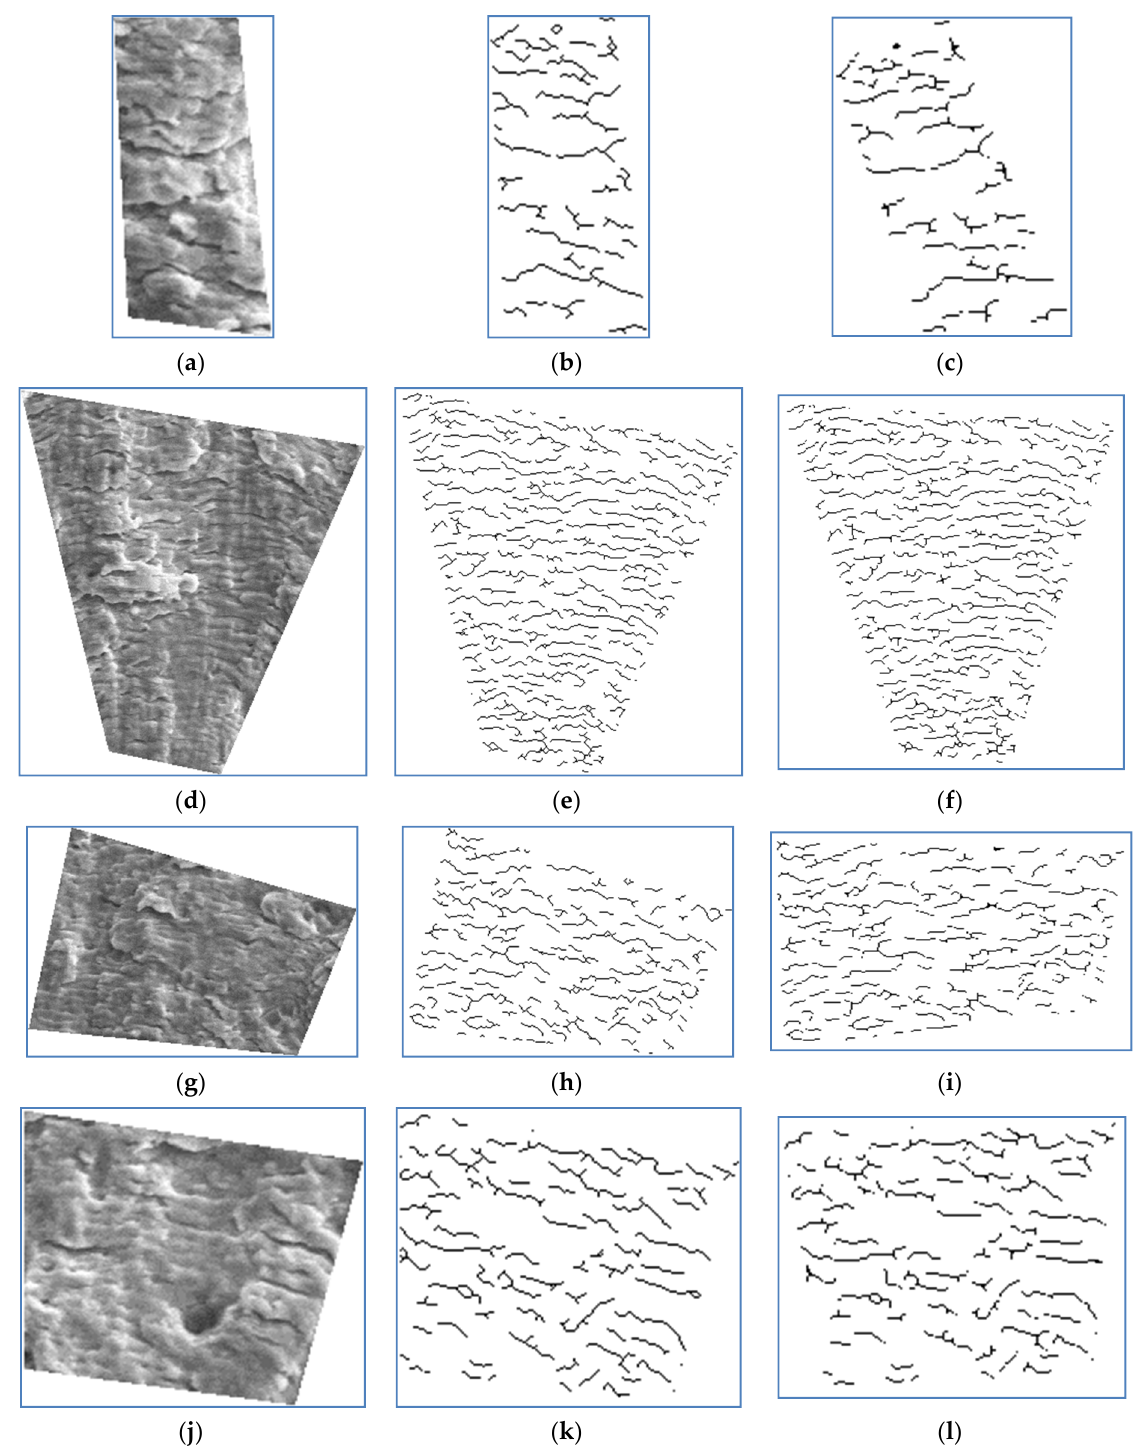
Figure 6. Fragments 1–4 ( a , d , g , j ), highlighted on the fractographic image in Figure 1, binary image of striations on fragments ( b , e , h , k ) and lines corresponding to the striations from fragments after rotation without changing the distance between them ( c , f , i , l ).